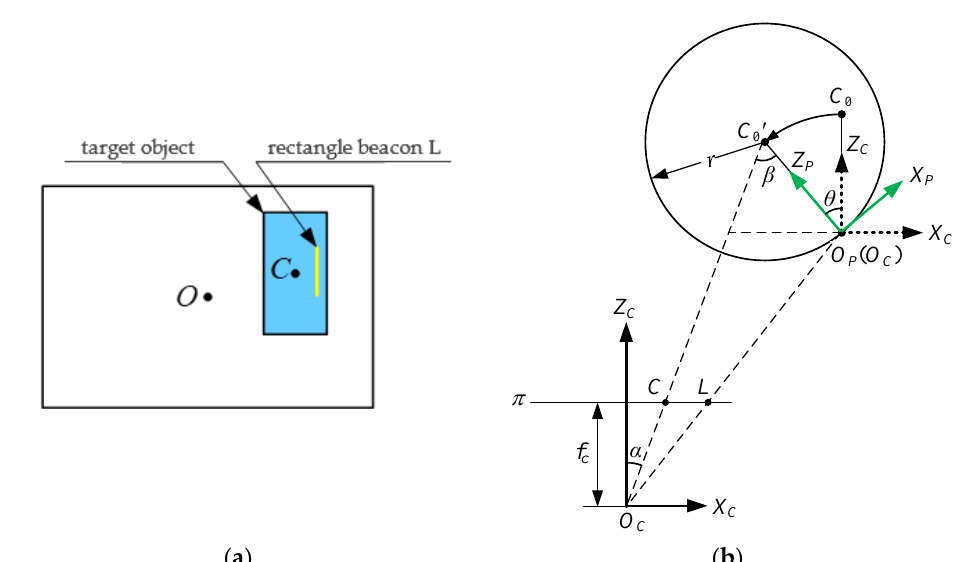
Figure 3. The projection and the Y P axis view of rotation only about the Y C axis. ( a ) The camera projects an image view as it rotates about the Y C axes. ( b ) Y P axial view.